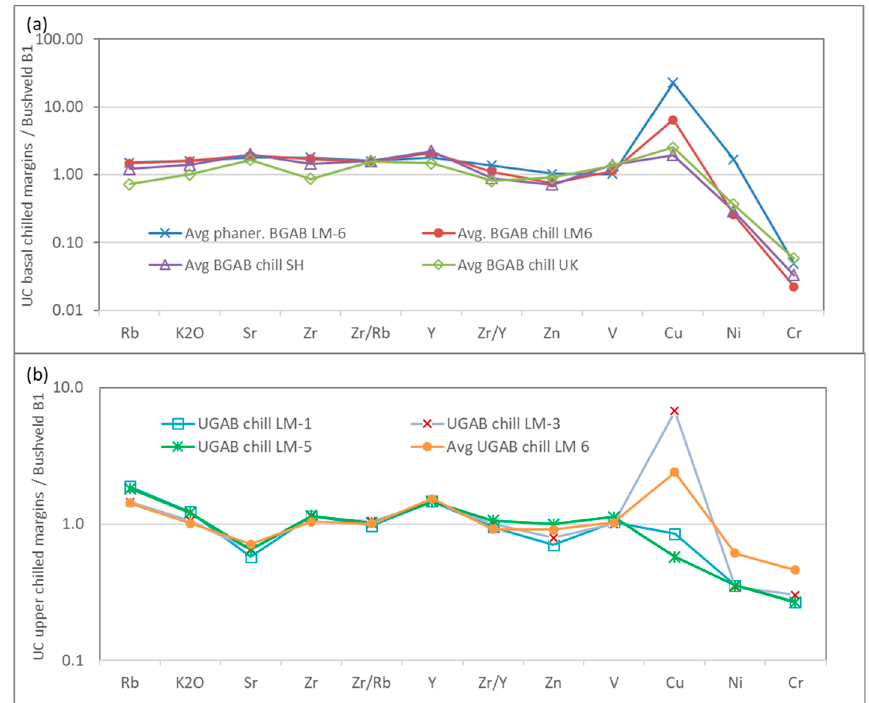
Figure 9. Minor element concentrations and ratios of rocks from ( a ) the Basal Gabbro unit at UK, SH and LM, and ( b ) the Upper Gabbro units of the UC at LM, normalised to Bushveld B1 micro-pyroxenite of [32].